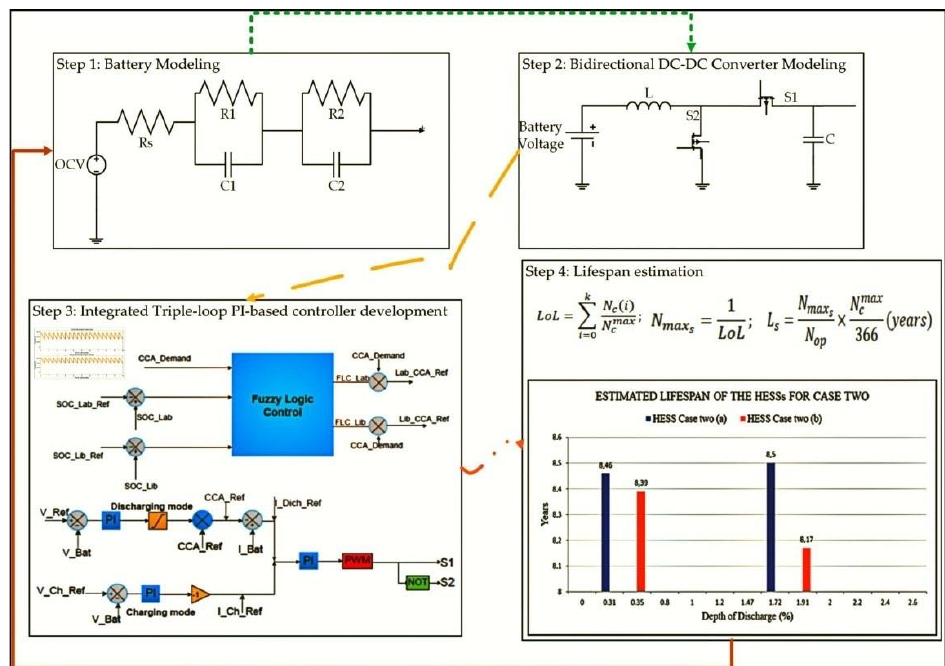
Figure 5. Experimental procedure for the developed HESS.